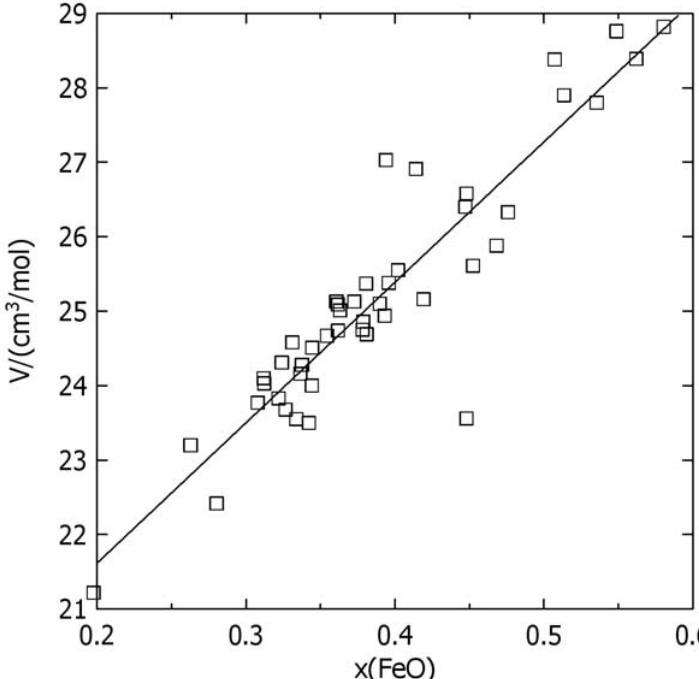
Fig. 3 Dependence of the molar volume of melts of the system CaO-FeO-Fe 2 O 3 -ZnO on the content of FeO at the temperature of 1573